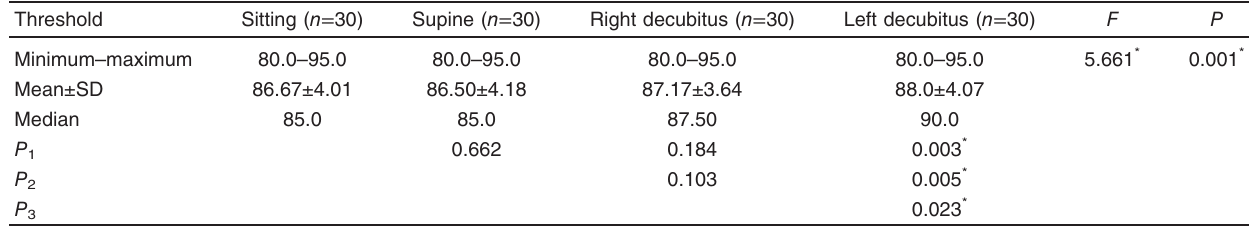
Table 3 Results of ocular vestibular-evoked myogenic potential threshold in the four positions (dBnHL)